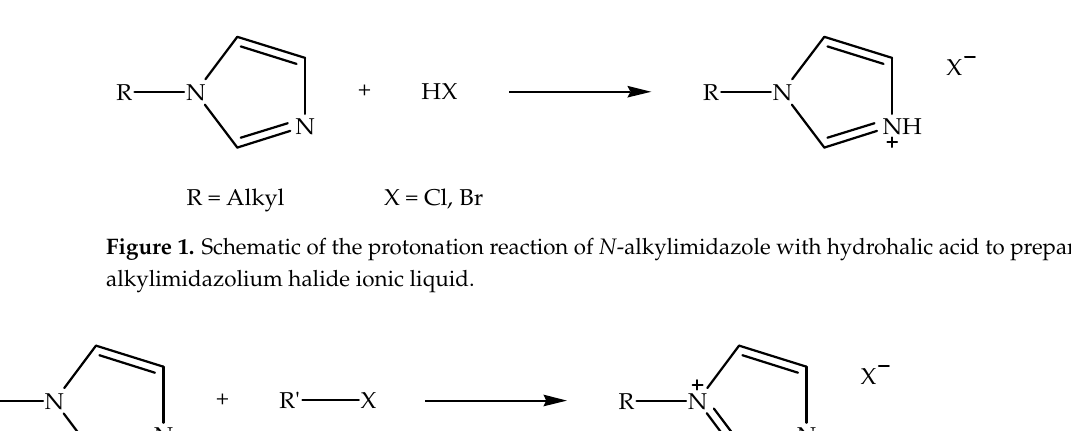
Table 3. Types of imidazolium-based ionic liquids, nanofillers, and modification processes of nanofillers. Ionic Liquid